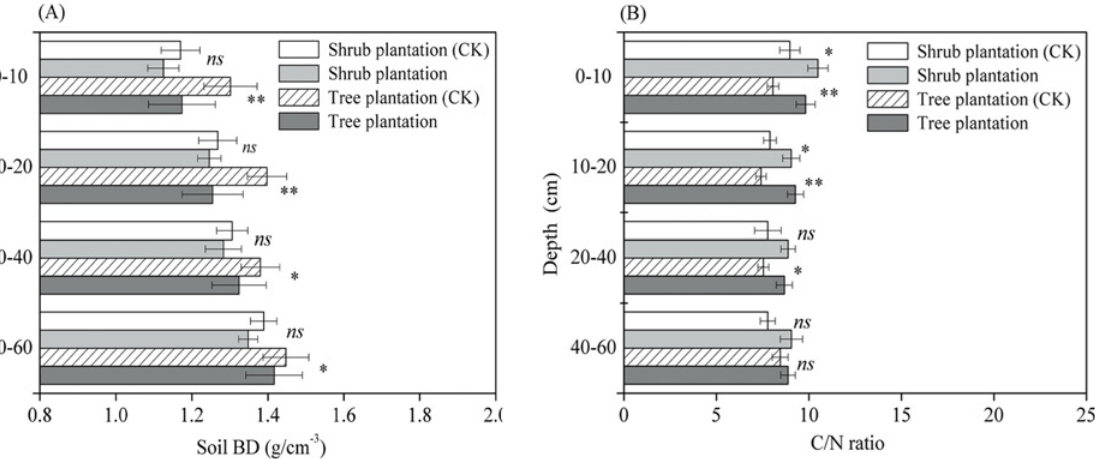
Fig 6. Comparing the mean soil BD (A) and C/N ratio (B) in afforested and reference (CK) plots at different soil layers across multiple sites on the Qinghai Plateau. The symbols of ** , * and ns represent the levels of significant differences between reference and forested plots at < 0.01, < 0.05 and > 0.05,